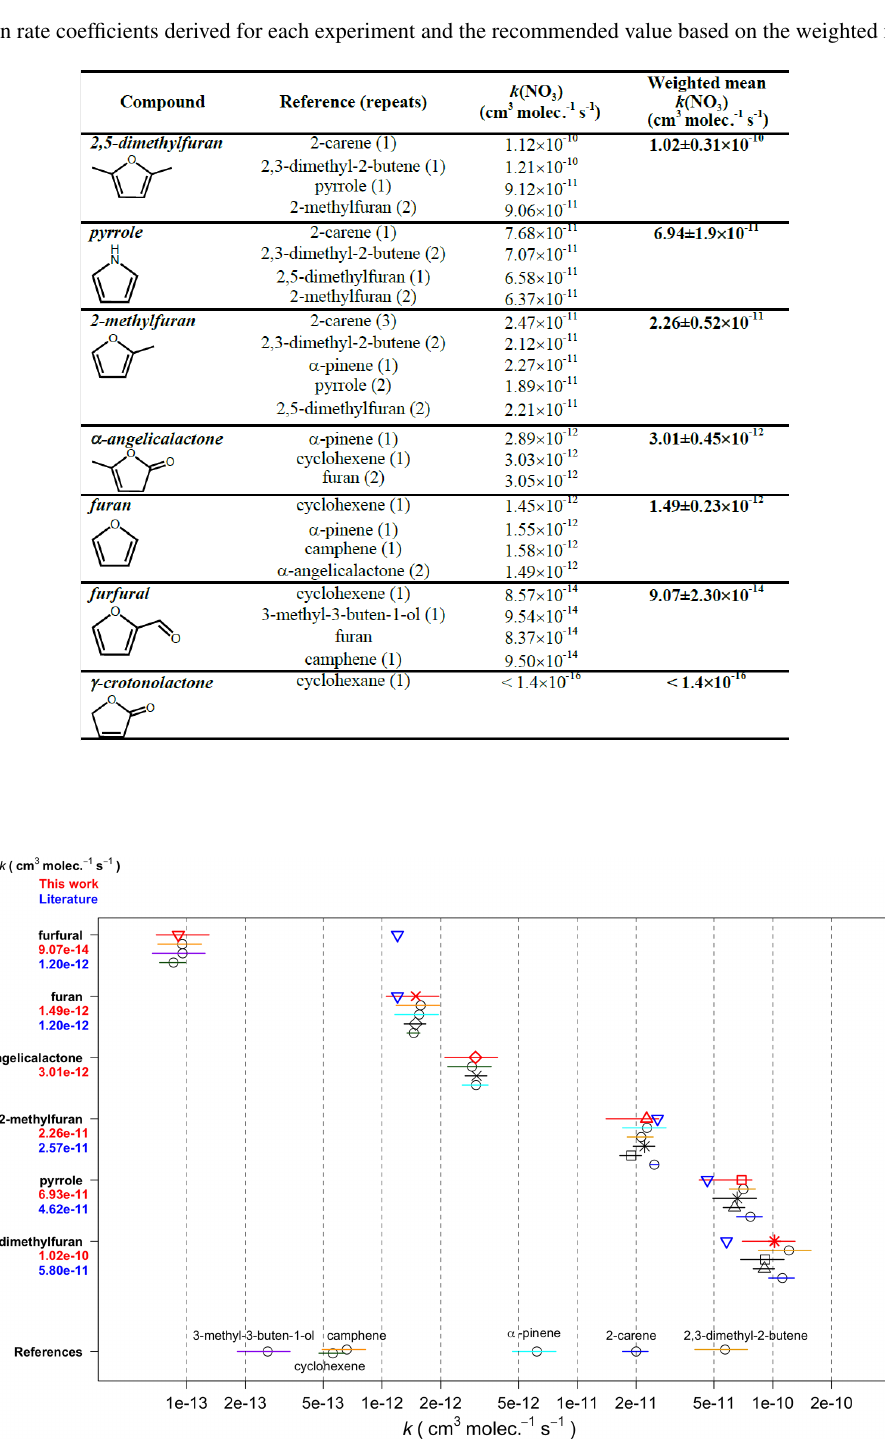
Figure 3. The reaction rate coefficients derived for the six compounds in this work (excluding γ -crotonolactone). Red triangles (and red text, left axis) represent the weighted mean of all experiments in this work, and blue inverted triangles (and blue text, left axis) are the recommended values from McGillen et al. (2020). Horizontal lines represent uncertainty in rate coefficient, and colours (shapes if other furans) represent which reference was